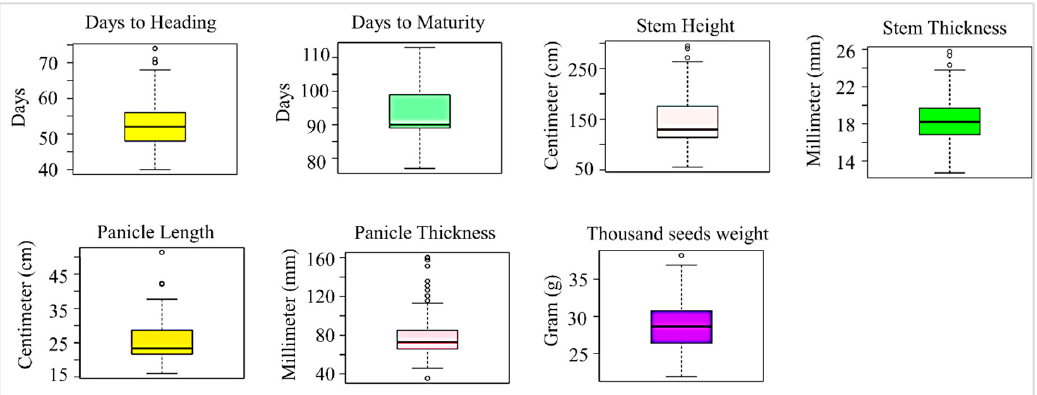
Figure 2. Boxplots showing variations in quantitative agronomical traits in sorghum landraces.